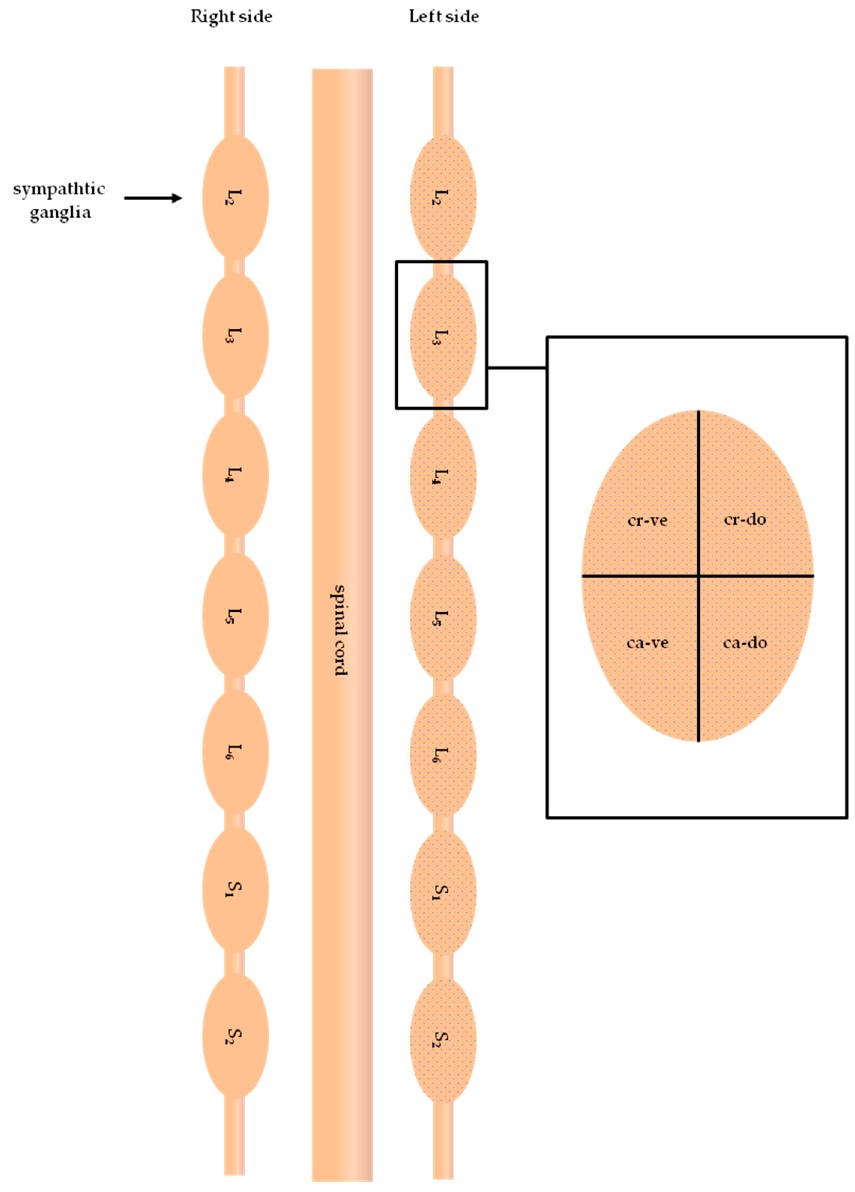
Figure 7. A schematic diagram of sympathetic chain ganglia (SChG) showing topographical subdomains in which the relative frequencies of skin projecting neurons were counted. cr-do, cranio-dorsal; cr-ve, cranio-ventral; ca-do, caudo-dorsal; and ca-ve, caudo-ventral subdomains of the